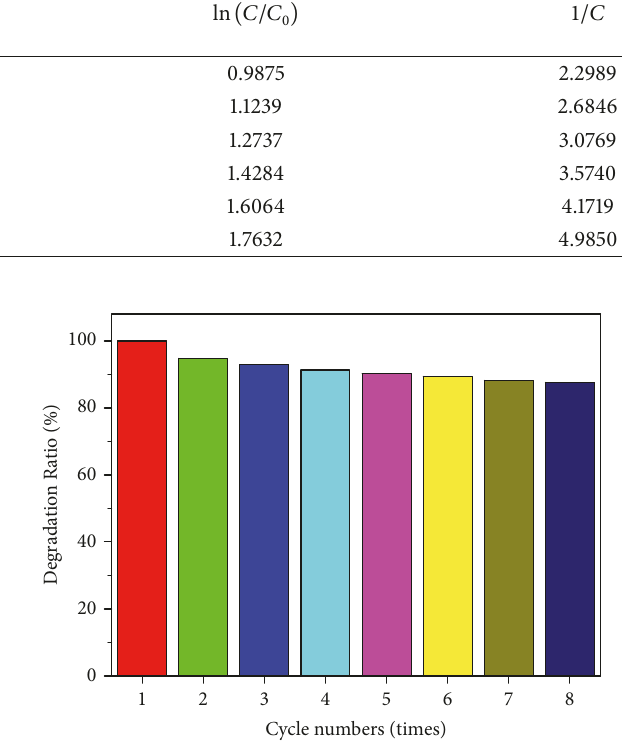
Figure 12: Degradation ratio of MB solutions in the presence of Sr 0.7 K 0.3 TiO 3−𝛿 @PC-polyHIPEs at eight cycle